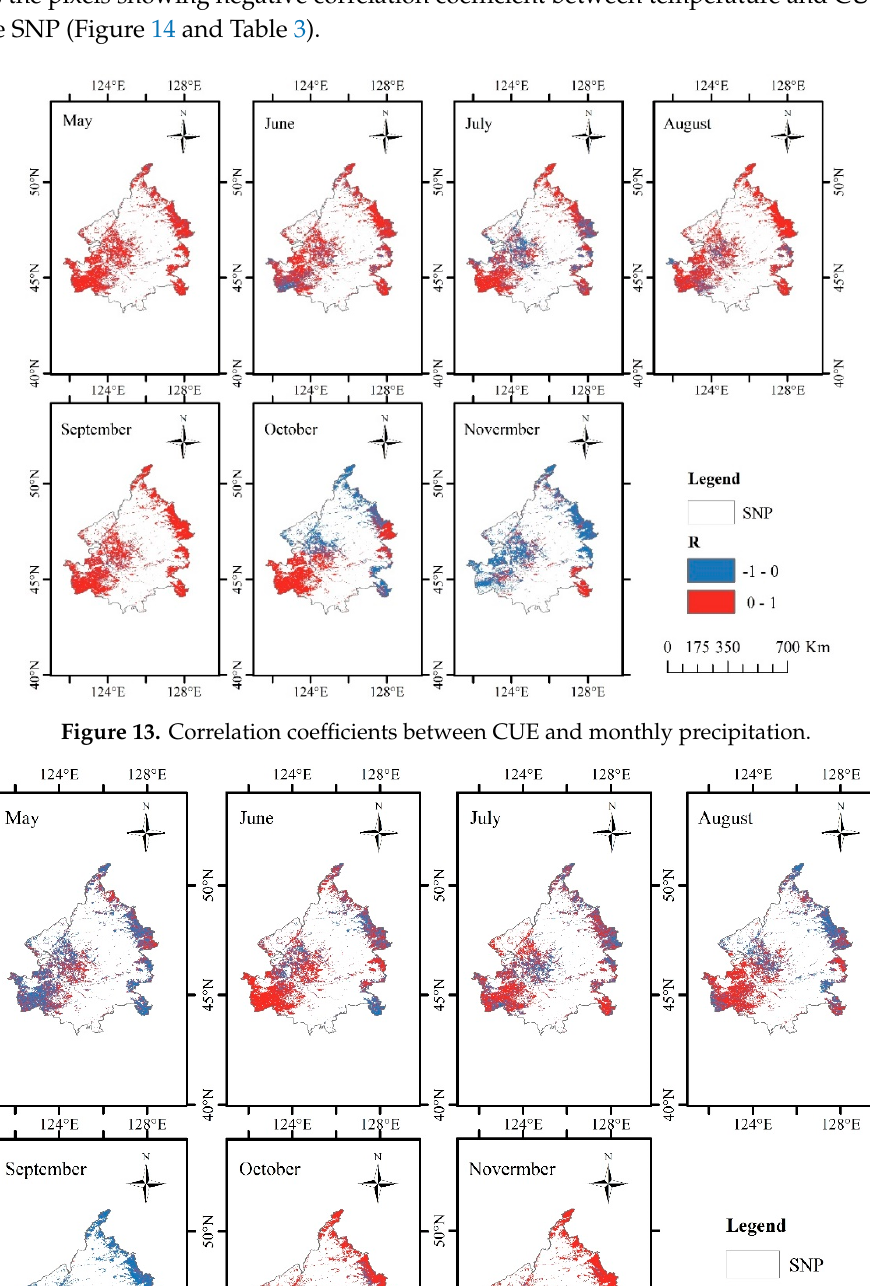
Remote Sens. 2019 , 11 , x FOR PEER REVIEW 14 of 20 Table 2. The number of pixels and their proportions of correlation coefficients between monthly precipitation and CUE.